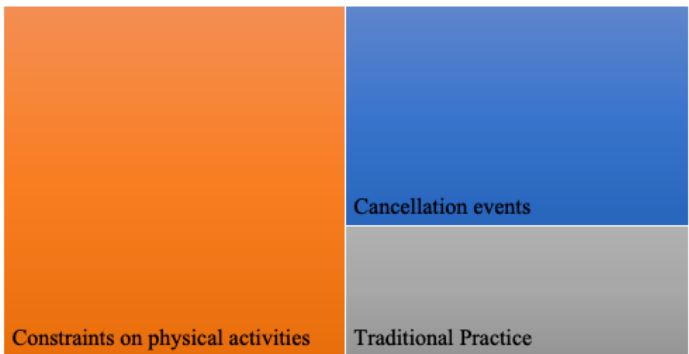
Figure 2. Name of sports in these